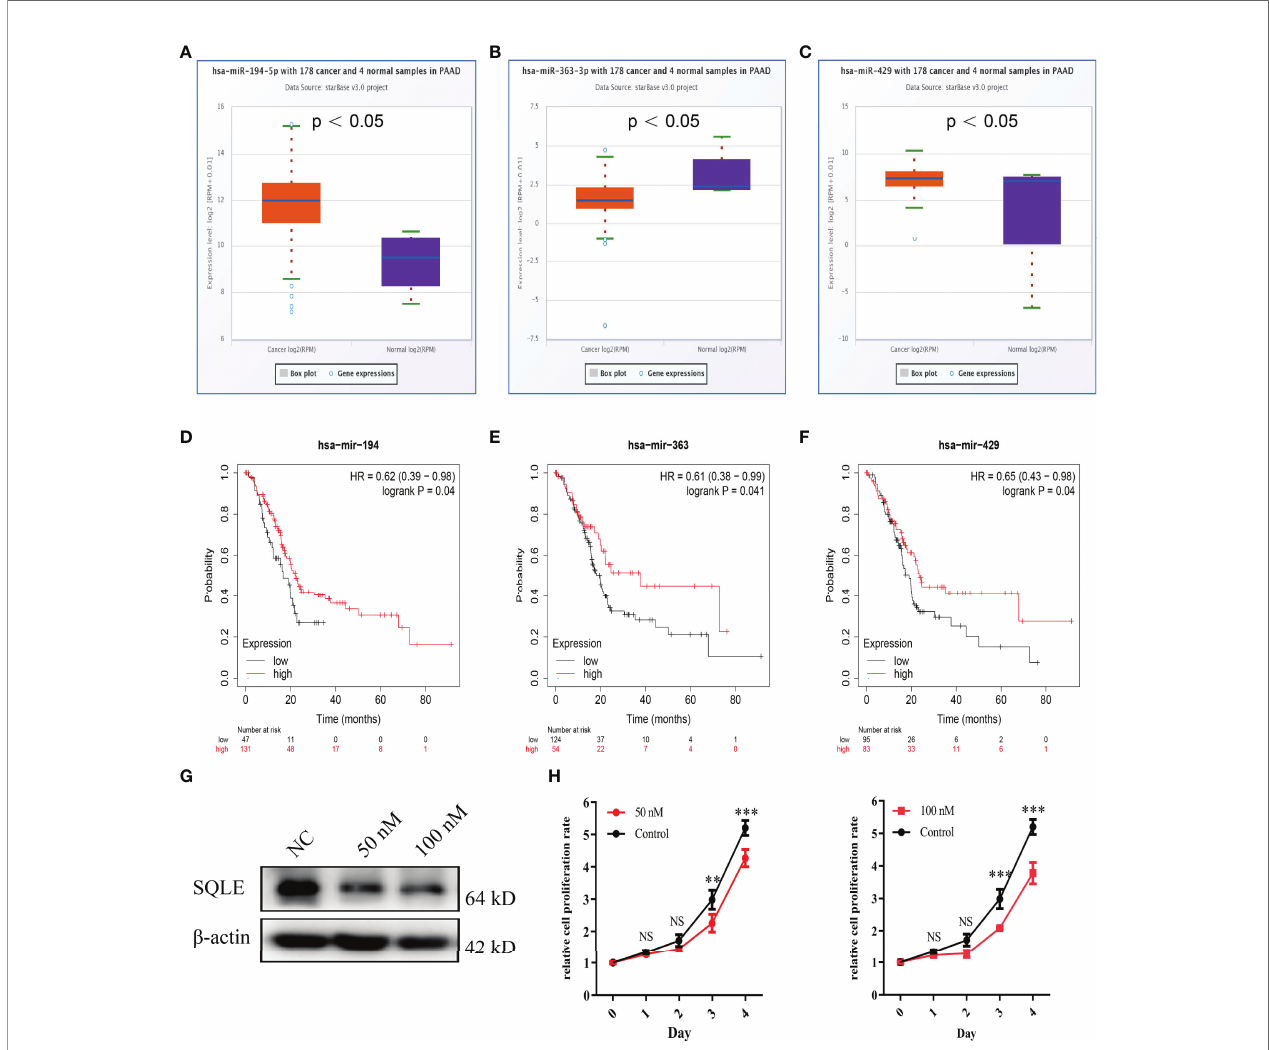
FIGURE 4 | Identi fi cation of miRNAs as potential upstream regulators of SQLE in PAAD. (A – C) Expression of miR-194-5p (A) , miR-363-3p (B) , and miR-429 (C) in PAAD and control normal tissues. (D – F) The prognostic values of miR-194-5p (D) , miR-363-3p (E) , and miR-429 (F) in PAAD obtained using the Kaplan- Meier plotter. (G) The SQLE knockdown ef fi ciency of 50 nM and 100 nM of miR-363-3p mimics on Day 2. (H) The effects of 50 nM and 100 nM of miR-363-3p mimics on in vitro proliferation in PANC-1. Two-way ANOVA test (n=3). **p value < 0.01; ***p value < 0.001; NS, no signi fi